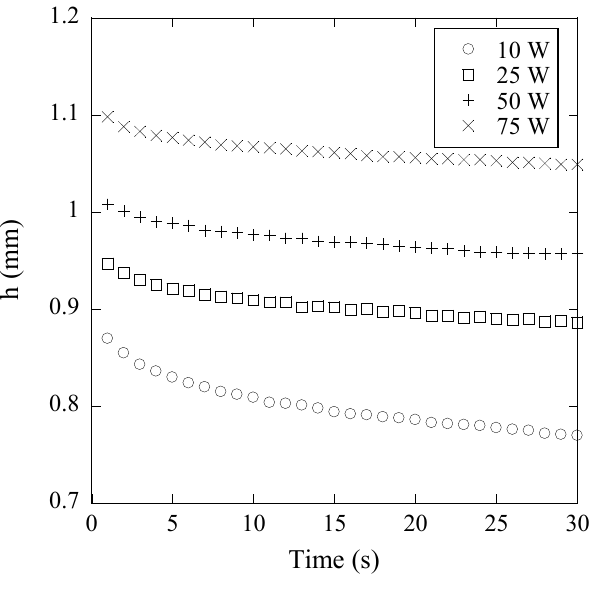
Figure 6. Experimental heights of the droplet on pp–GT thin